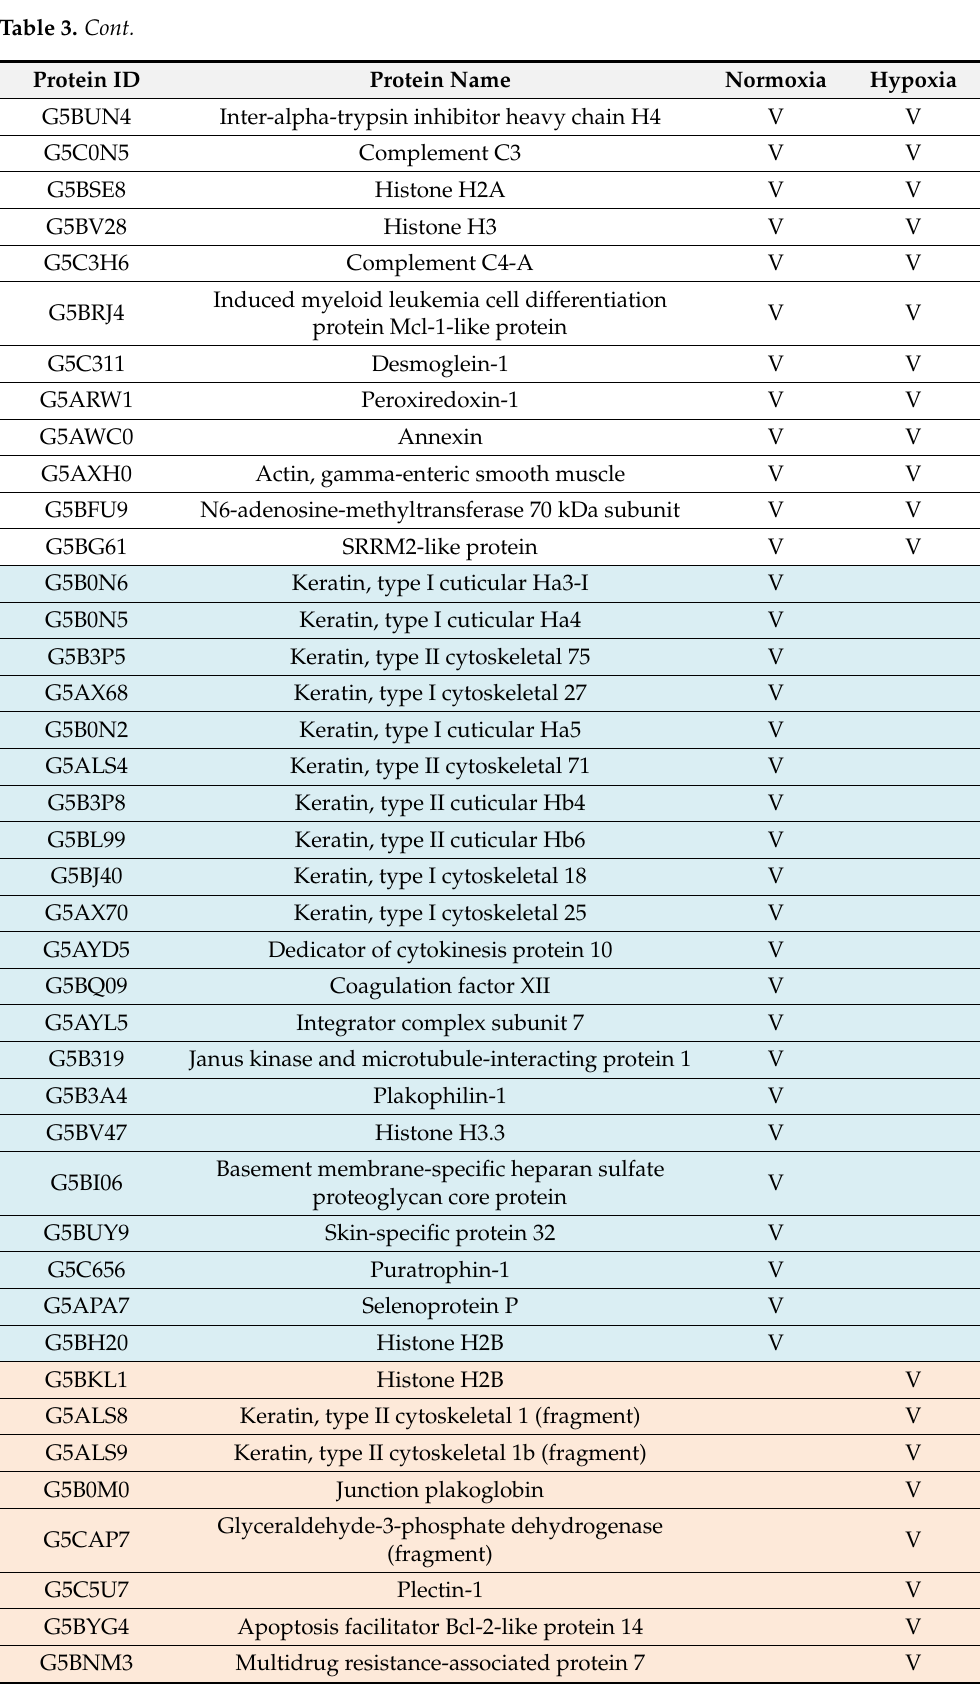
Table 3. Cont. Protein